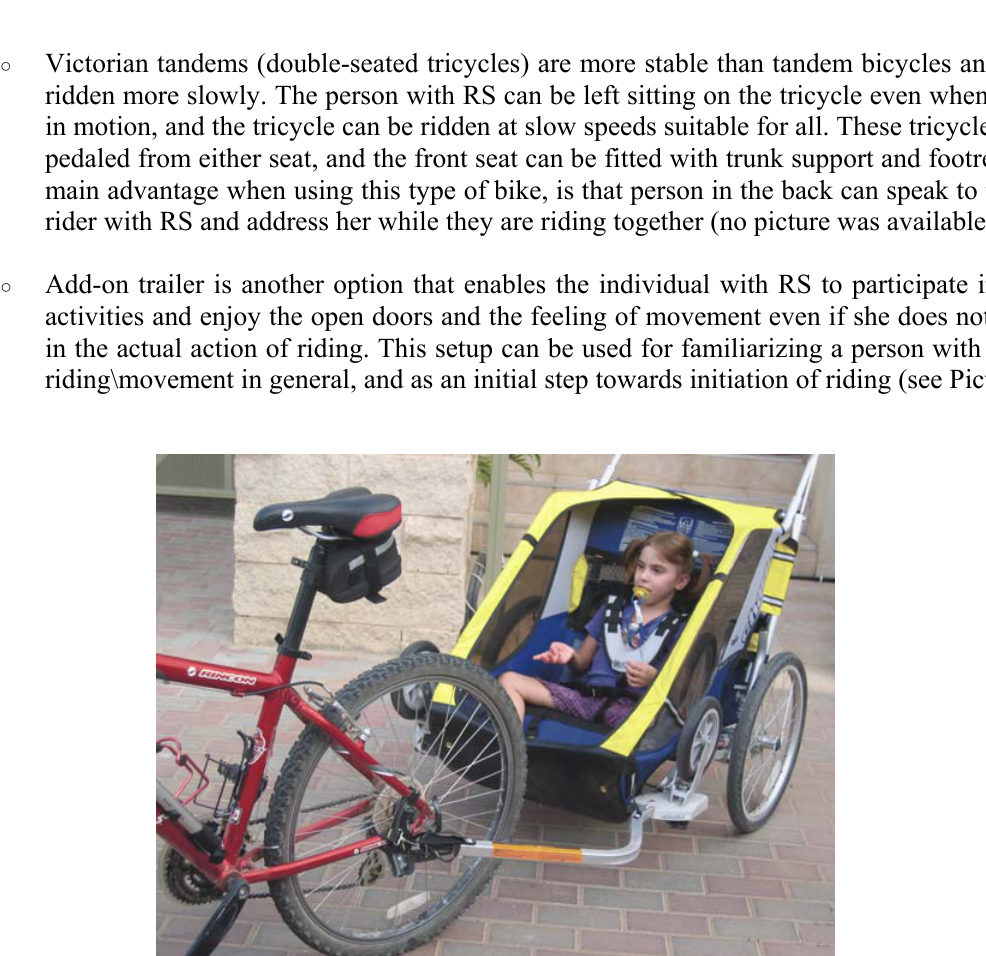
PICTURE 30. Tandems